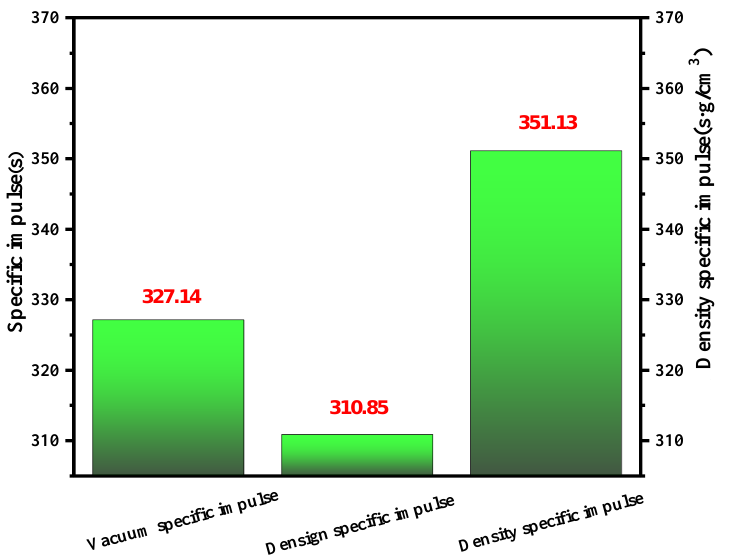
Figure 11. Vacuum density specific impulse, design specific impulse and vacuum specific impulse of (1-methylimidazolium)(tetrazol-1-yl)borane.